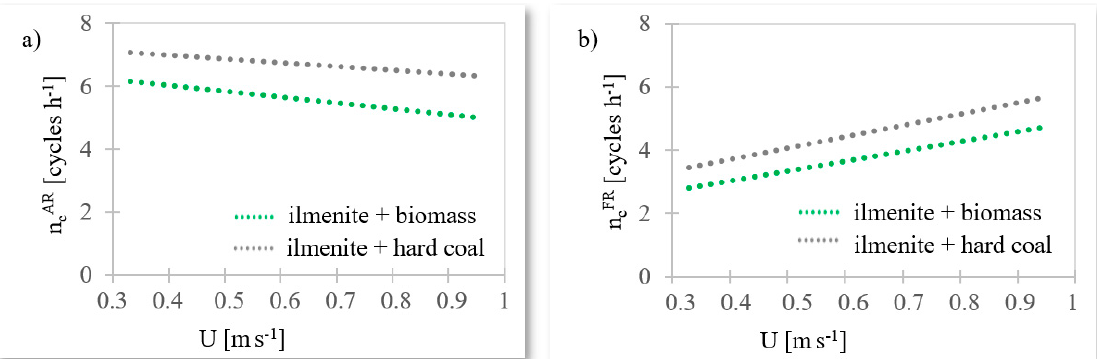
Figure 17. The number of ilmenite cycles in reactors versus superficial gas velocity in the FR ( a ) AR; ( b ) FR.